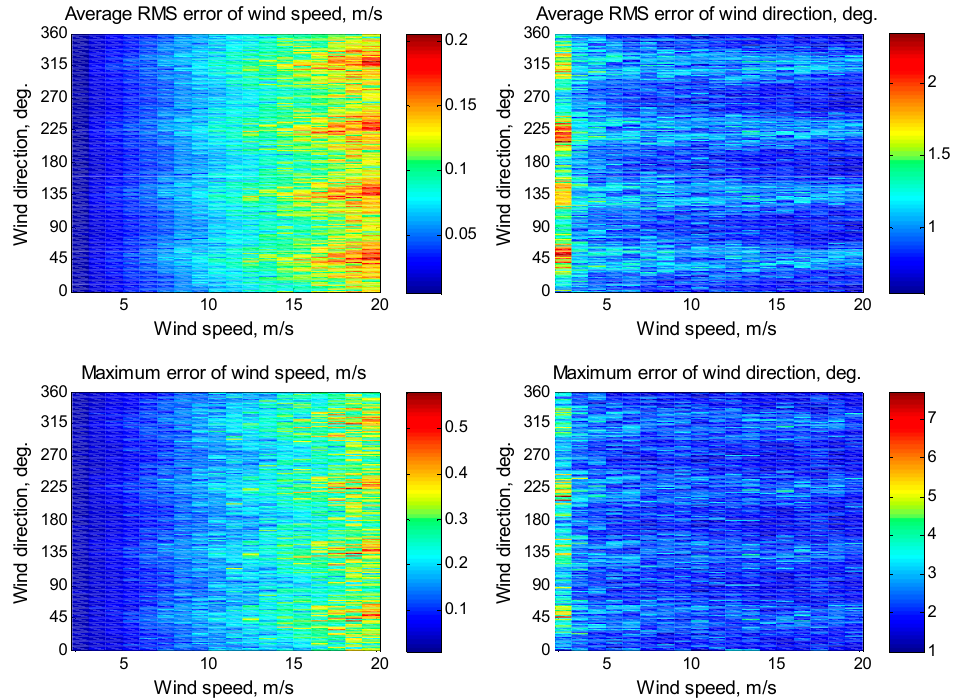
Figure 10. Simulation results for the mounting angle of a beam axis in the horizontal plane of 45 ◦ with the assumption of 0.2 dB instrumental noise at wind speeds of 2–20 m/s for the incidence angle of 45 ◦ with 1565 averaged NRCS samples for each azimuthal angle.